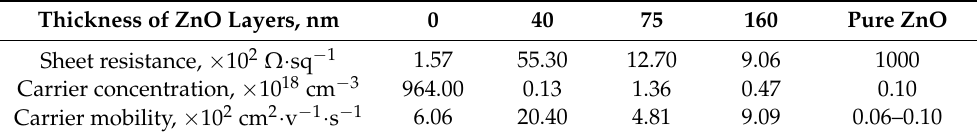
Table 1. Electrical properties of the amorphous ZnO/graphene composite film.